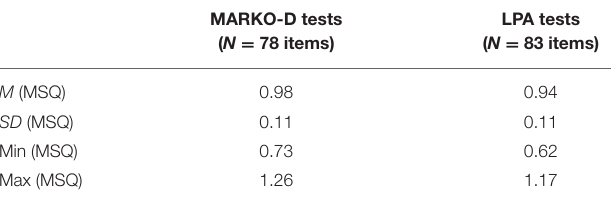
TABLE 2 | Item fit statistics of the measurement instruments. TABLE 3 | Descriptive statistics of person parameters from MARKO-D tests and